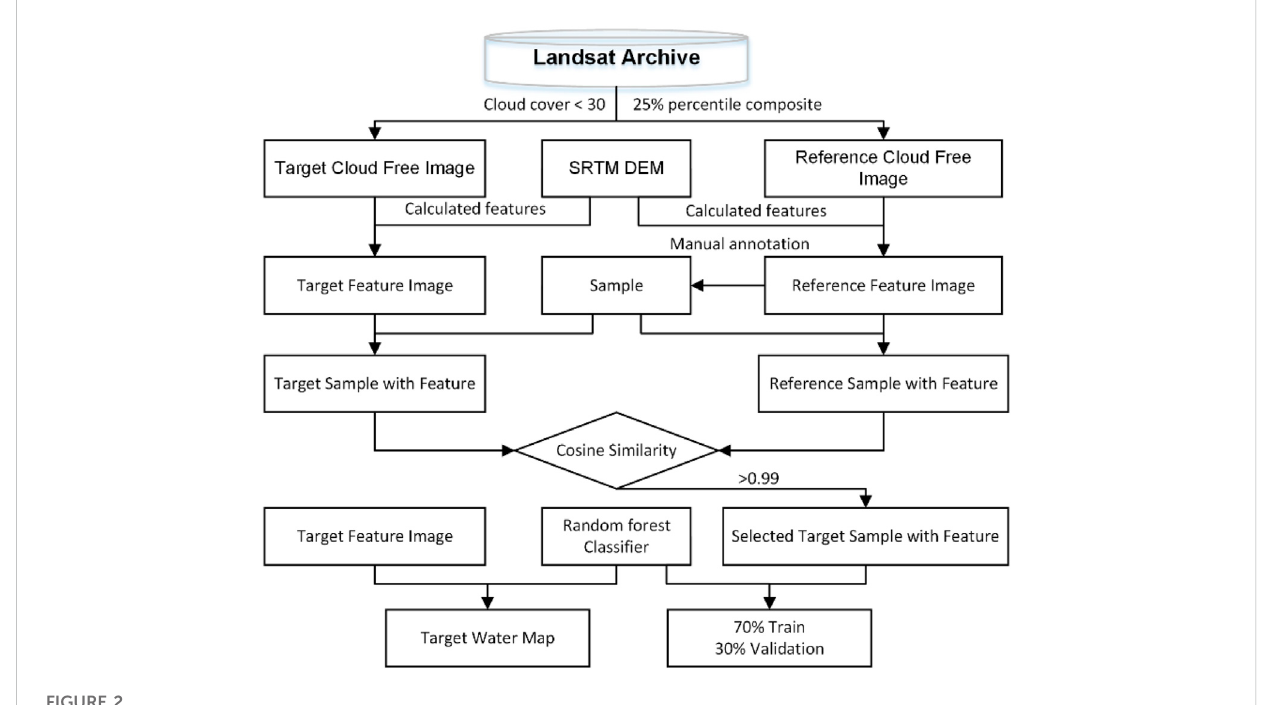
FIGURE 2 The fl owchart of surface water extraction.